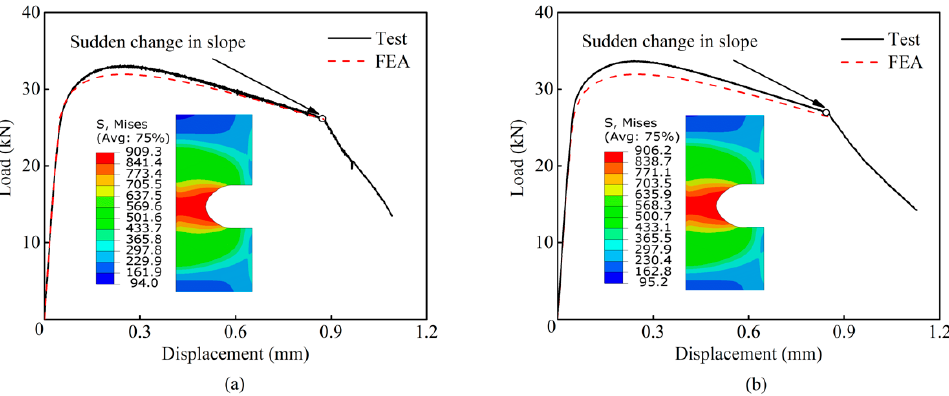
Figure 6. Numerical results of X80 pipeline steel for the SNT tensile specimens (R = 1.5 mm): ( a ) Specimen M1; ( b ) Specimen M2.